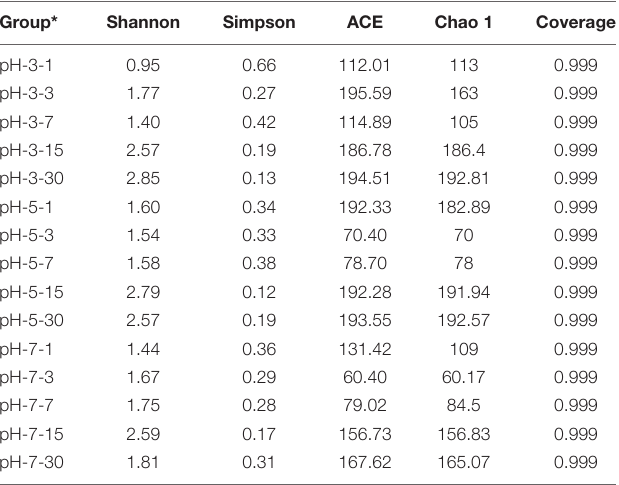
TABLE 2 | Variation of α diversity indexes under different pH.